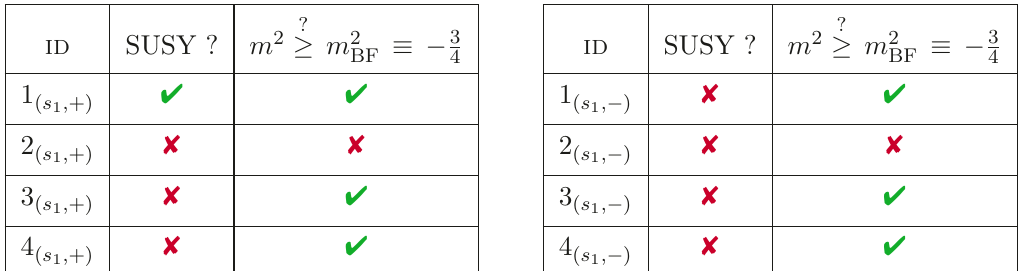
Table 6 . Properties of the eight different AdS 4 Inequivalent solutions are labeled according to the sign s 2 . The second column shows whether the solutions are supersymmetric ( ✔ ) or not ( ✘ ) and the third whether all the masses of the 2 + 6 2 dof’s are above the BF bound ( ✔ ) or if some are below ( ✘